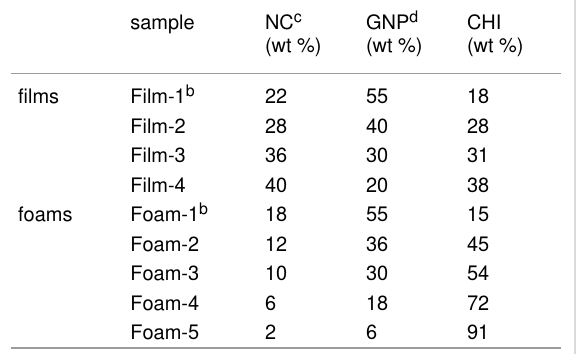
Table 2: Composition and nomenclature of the prepared samples.